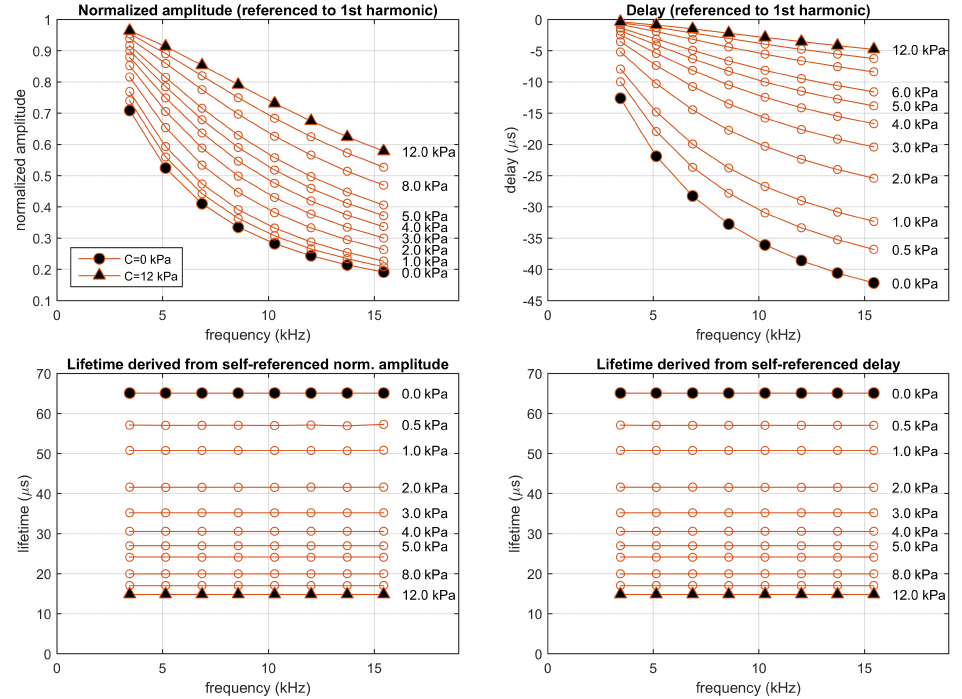
Figure 6. Simulation of the one-site model fitting the experimental luminescent system ( M 0 = 2.2089, τ 0 = 65.0889 µ s, and k = 0.2826 (kPa) − 1 ), excited in the experimental conditions (rectangular pulses presented at a fundamental frequency of 1715 Hz with a 10% duty cycle). Top panels : Normalized amplitudes and delays referenced to the first harmonic; bottom panels : corresponding self-referenced lifetimes. Each point correspond to one harmonic (from 2nd to 9th).